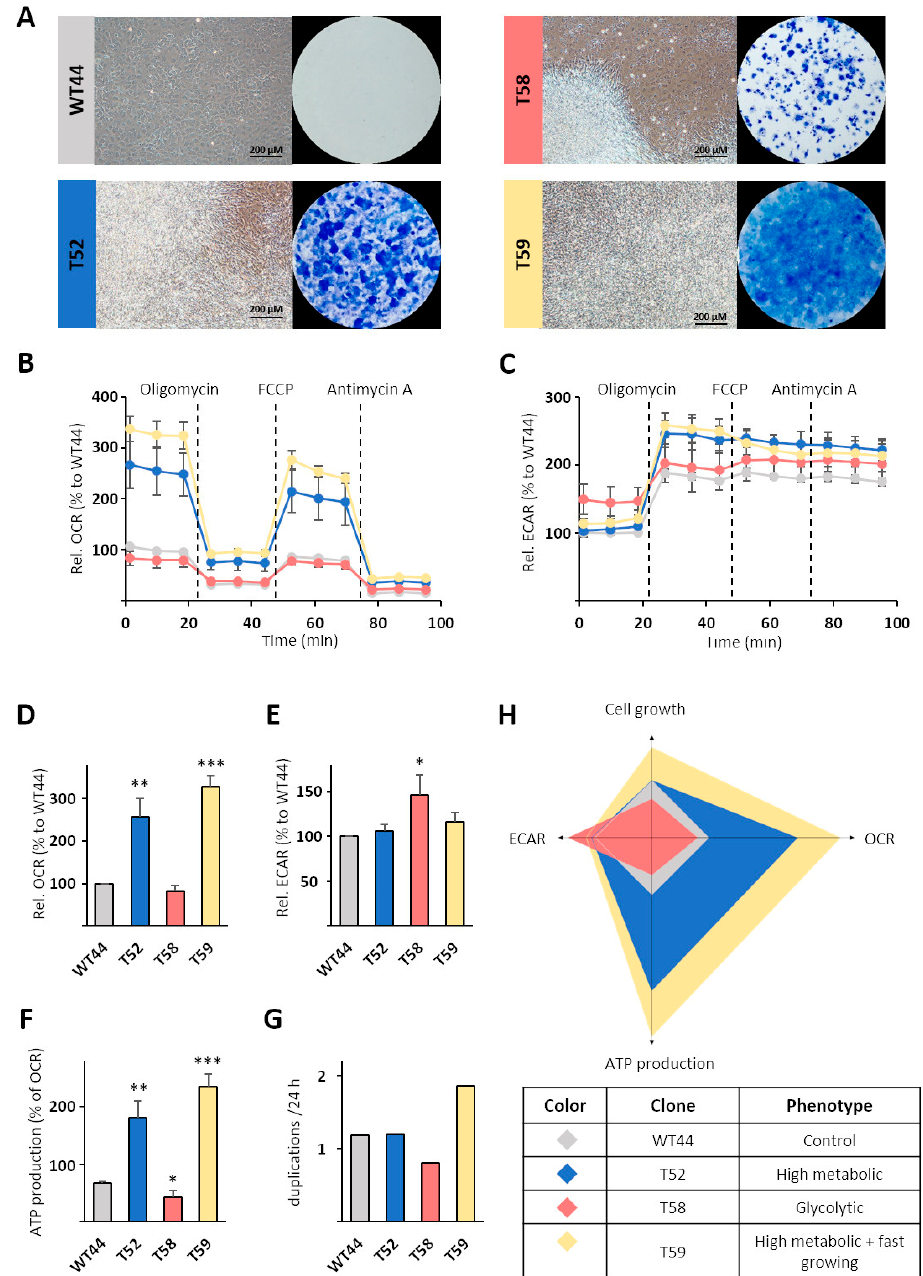
Figure 3. Characterization of monoclonal cell lines. The metabolism of the non-transformed cell clone WT44 and the three MCA/TPA transformed cell clones T52, T58, and T59 was analyzed. ( A ) Cells were cultivated for 16 days, fixed with methanol, and stained with Giemsa solution. A Cell Mito Stress Test was performed using an XFe24 Analyzer and ( B ) the oxygen consumption rates (OCRs) and ( C ) extracellular acidification rates (ECARs) were measured simultaneously. ( D ) Basal respiration and ( F ) mitochondrial ATP production were calculated from OCR values. ( E ) All values are shown relative to the non-transformed cell clone WT44. ( G ) Cell clones were fixed at several points in time and their cell density was quantified with sulforhodamine B (SRB) dye (see methods). The duplications per 24 h were calculated within the linear range of the resulting growth curves from one experiment. ( H ) The different metabolic phenotypes of individual cell clones are illustrated. Data in ( B – F ) are shown as the mean + SEM from three biological replicates. Statistical differences were calculated via a two-sided t -test with * p < 0.05, ** p < 0.01, and *** p < 0.001 vs.